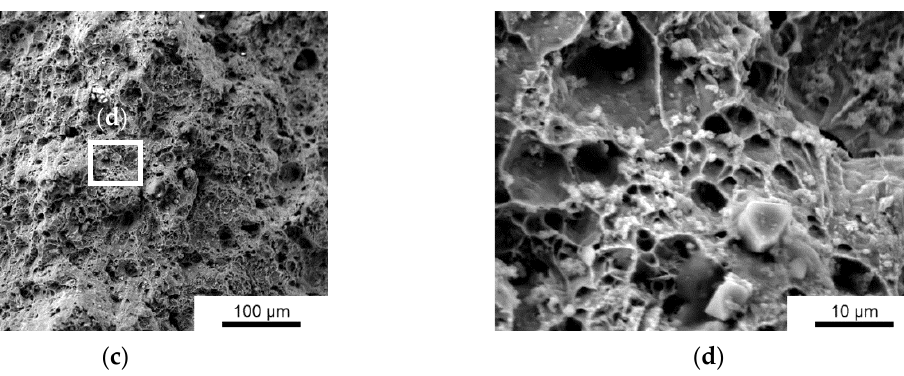
Figure 15. Fractography of ZnAl-coated (II) specimen tested in 3.5% NaCl solution at 300 MPa and: ( a ) overview, ( b ) area of crack initiation, ( c ) area of sudden failure and ductile dimple fracture and ( d ) area of sudden failure and ductile dimple fracture at higher magnification.